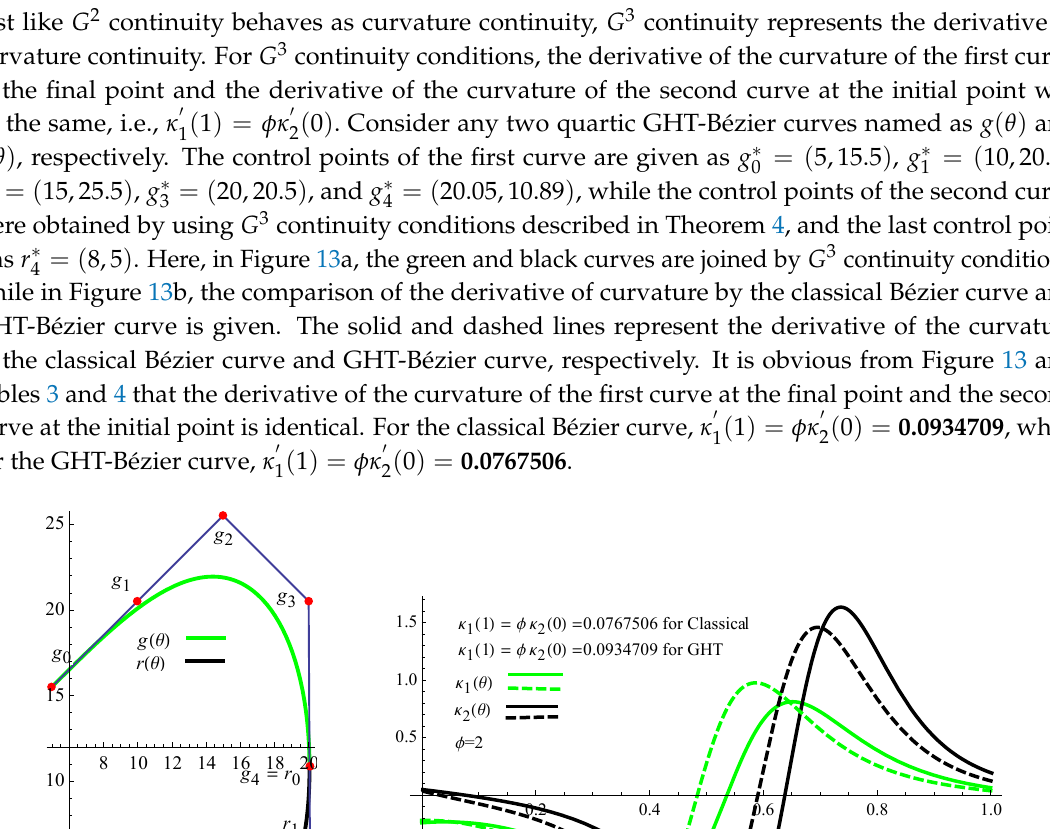
Solid lines for curvature off Classical Bezier curve Dashed lines for curvature of GHT-Bezier curve